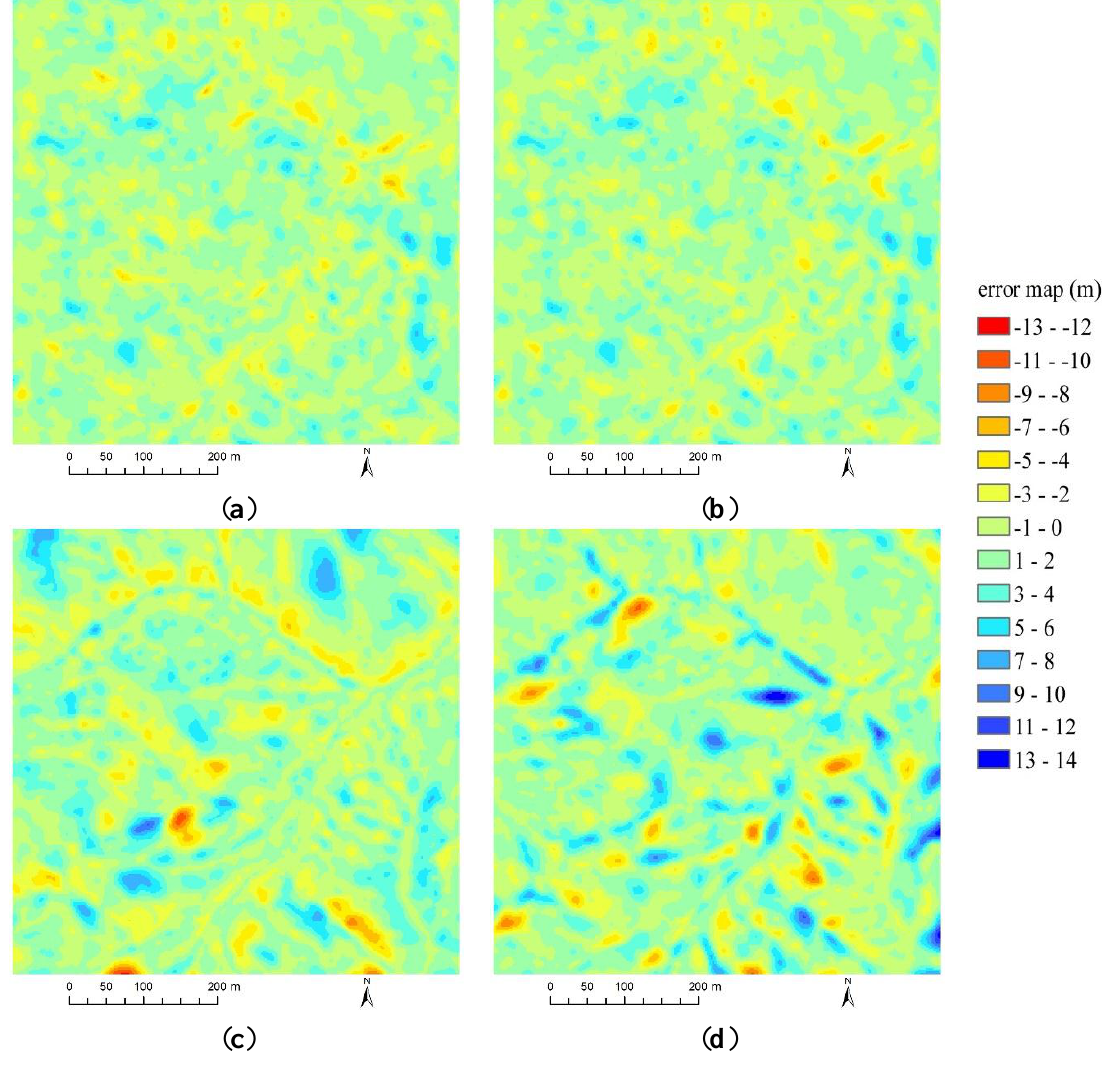
Figure 10. Error maps of ( a ) TPS-F, ( b ) TPS-W, ( c ) max-Z and ( d ) random with1% of LiDAR points in the hilly